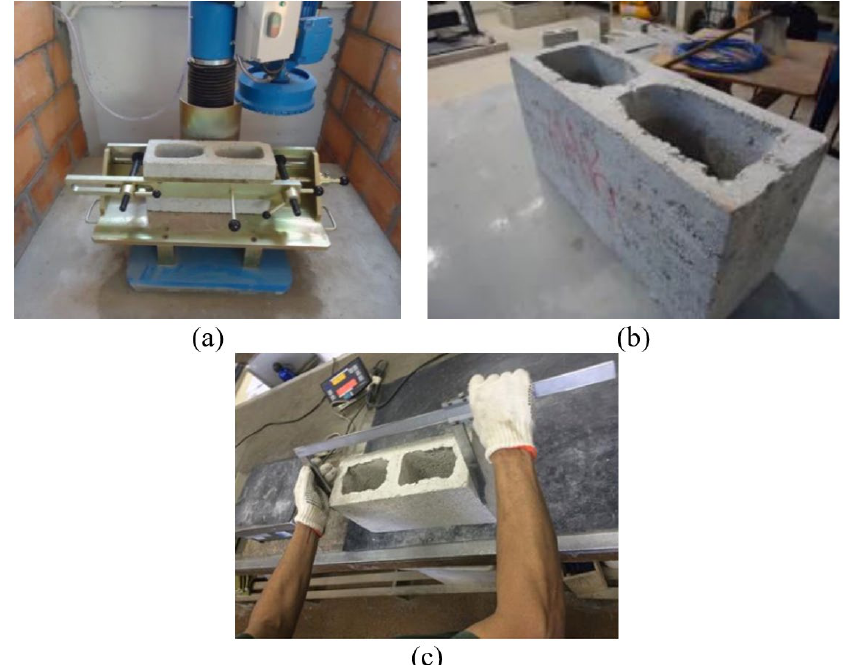
Figure 1. (a) grinding process, (b) rectified block and (c) dimension measurement. Source: Tchalekian